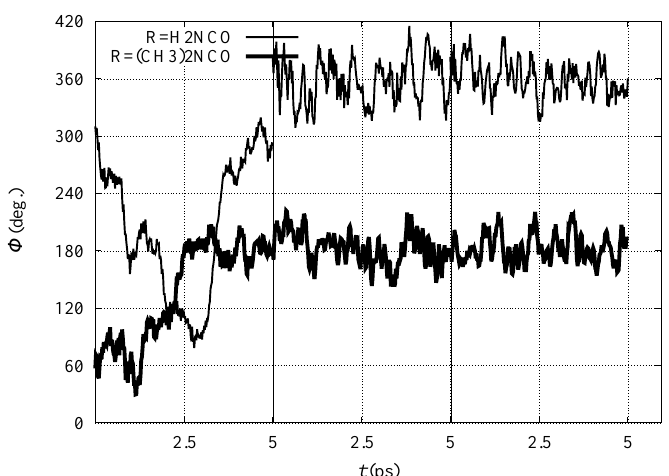
NCO (thin line) 2